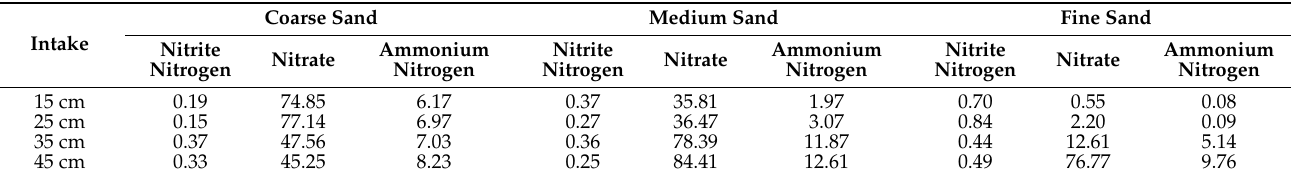
Table 2. Initial concentration of